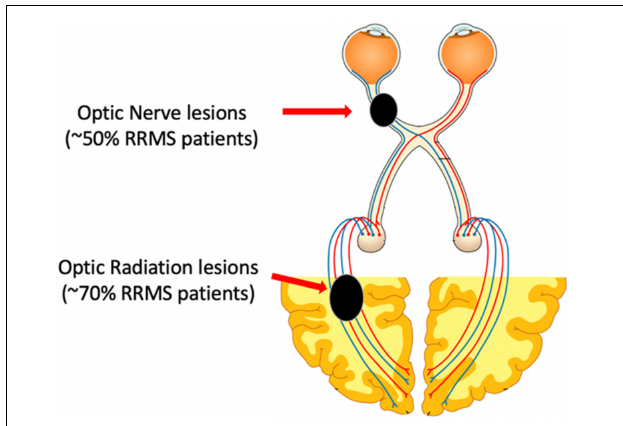
FIGURE 2 | Tractography of the optic tract (green) and optic radiation using ConTrack